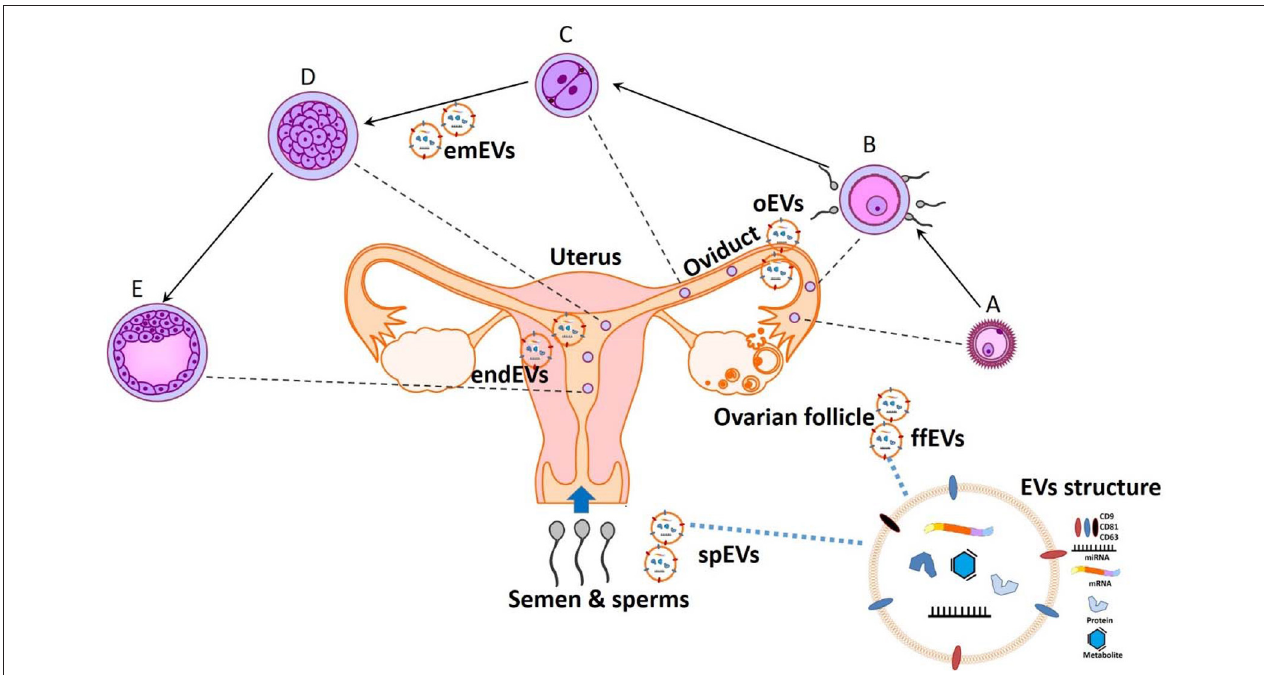
FIGURE 1 | The potential theranostic approaches for embryonic-maternal microenvironments. A- Ovulated oocyte, B- Fertilization, C- Zygote cleavage, D-Morula, and E- Blastocyst formation. Extracellular vesicles (EVs) are secreted in all reproductive fluid including seminal plasma (spEVs), follicular fluid (ffEVs), oviduct (oEVs), and endometrium (endEVs), as well as from the gametes and preimplantation embryos (emEVS). Recent advances in analyzing the cargo contents of EVs will provide a paradigm for diagnostic and designing therapeutic tools for improving or opposing the reproductive